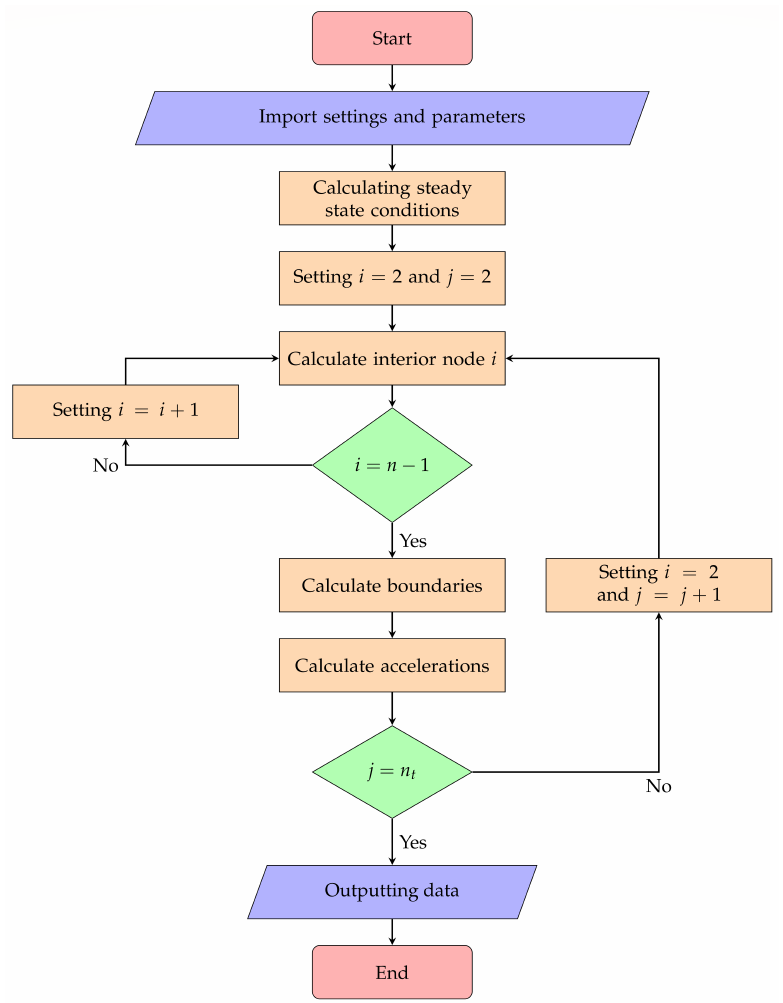
Figure A1. Flow chart of the MOC